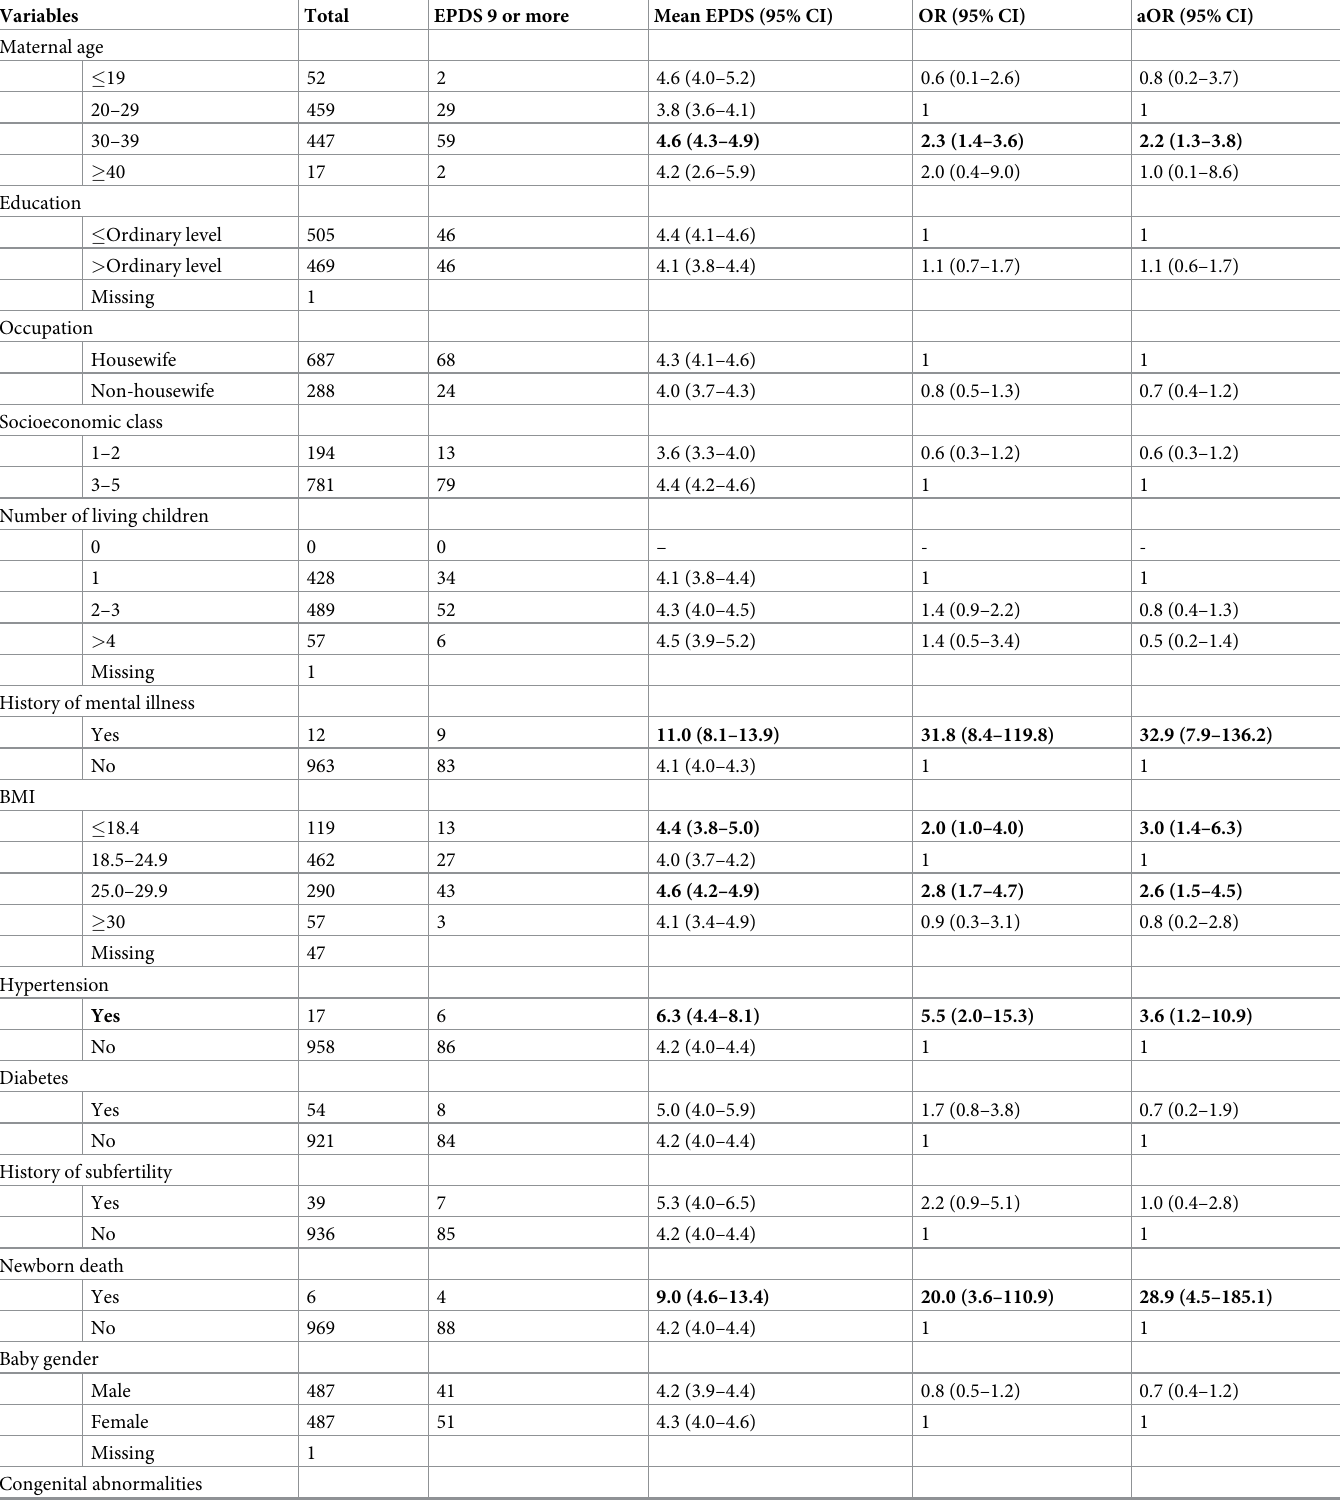
Table 2. Determinants of EPDS score 9 or more (risk of PPD) among mothers in Galle,